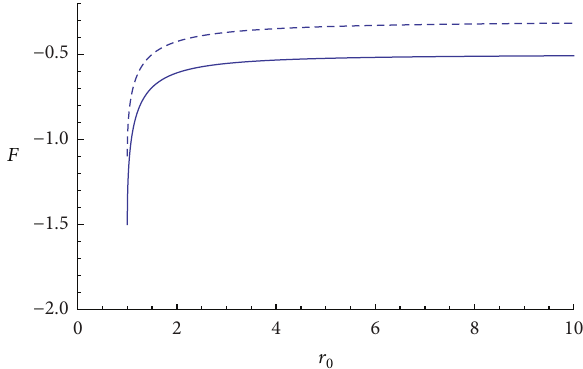
Figure 1: The free energy depending on 𝑟 0 for 𝜂 = 0 (solid) and 𝜂 = 1 (dashed), where we set 8𝜋𝐺 = 1 , 𝑟